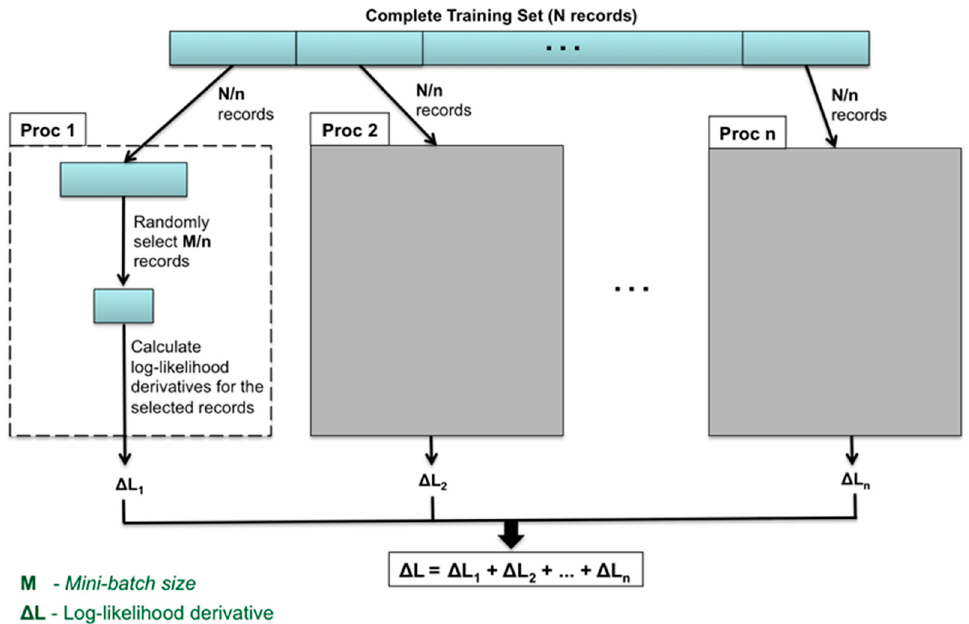
Figure 1. Schematic diagram illustrating the strategy used for parallelizing the calculation of log-likelihood derivatives.